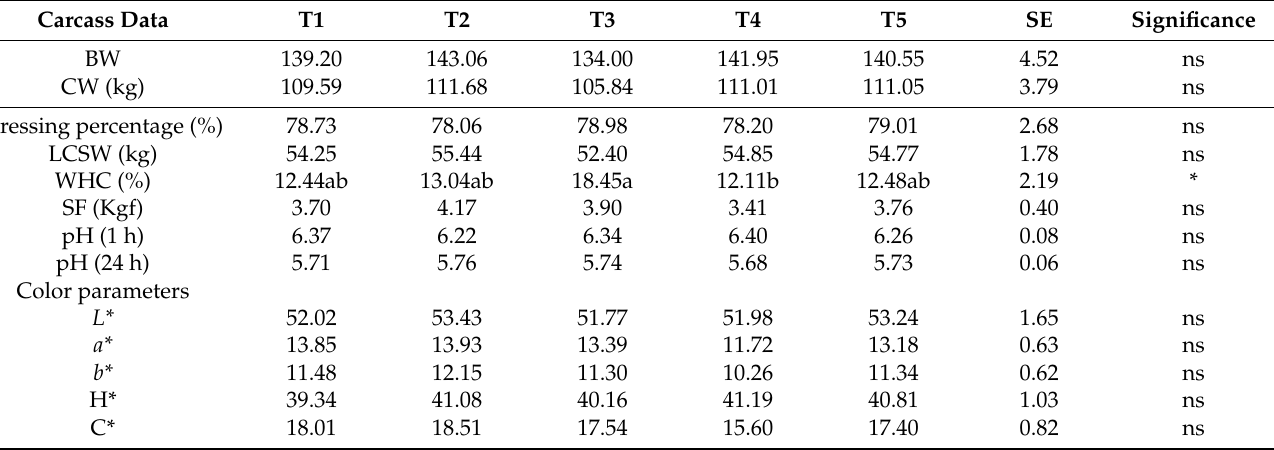
Table 3. Effect of different olive cake treatments on carcass and physical meat characteristics of B í saro pigs.